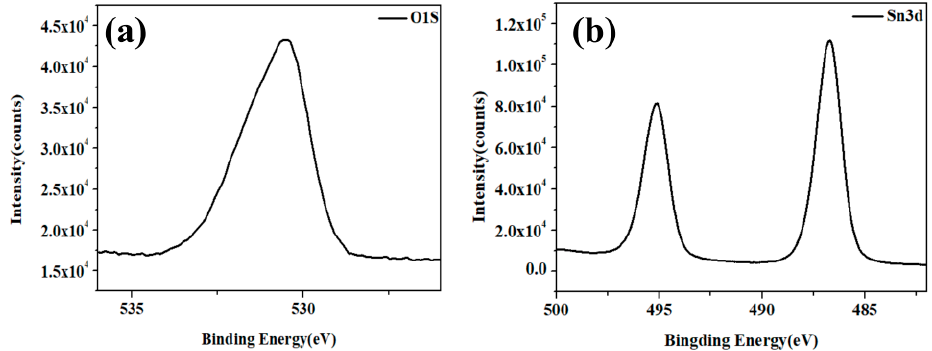
Figure 3. ( a , b ) The survey of XPS spectra of the SnO 2 film on the FTO substrate.